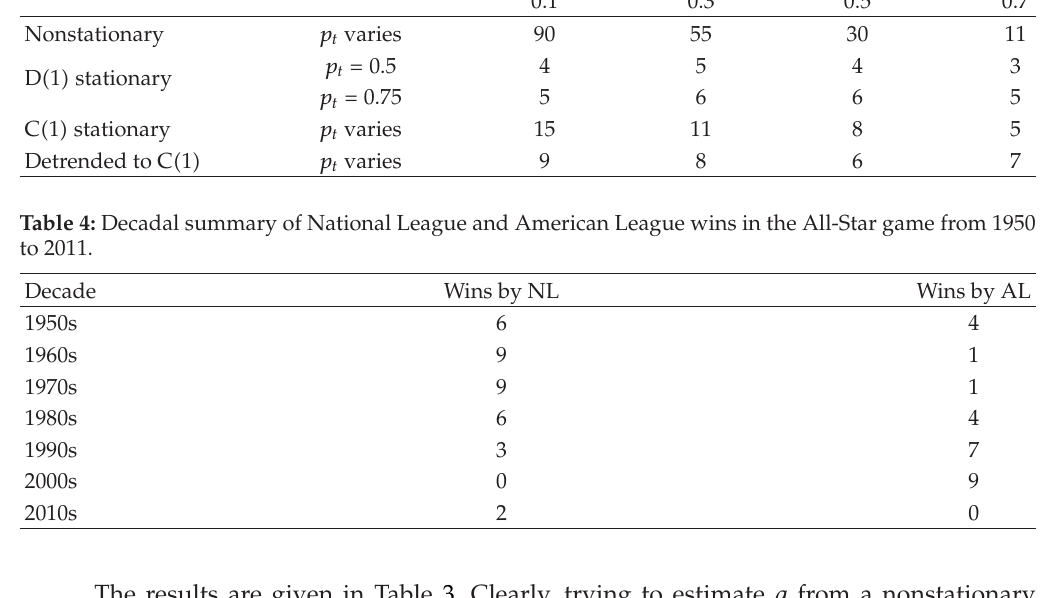
Table 3: MSE times 1000 for the estimate of q for di ff erent degrees of stationarity. Model True value of q 0.1 0.3 0.5 0.7